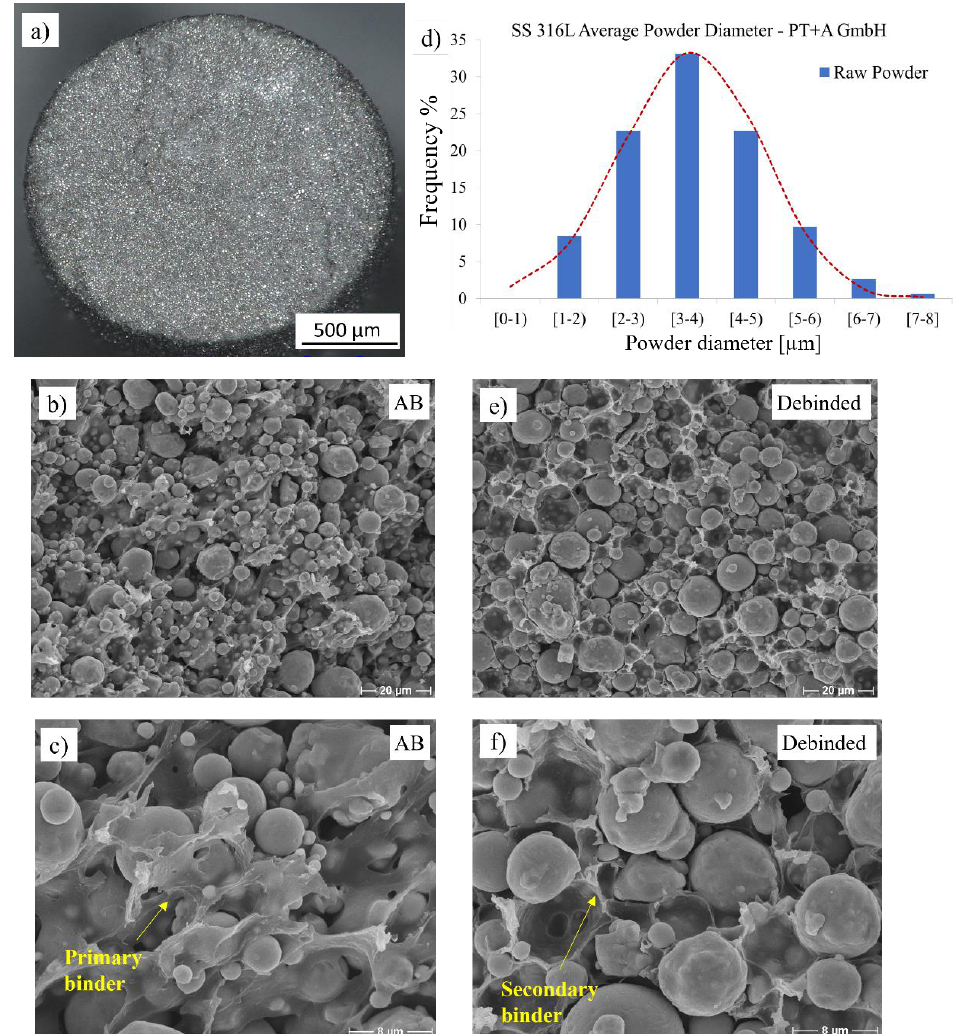
Figure 3. ( a ) Raw filament cross-section at mag. 50 × , ( b ) micrograph of feedstock with stainless steel 316L powder embedded by polymeric binder at mag. 1000 × and ( c ) mag. 3000 × , ( d ) particle size distribution of measured powder in the debinded state, ( e ) micrograph of the debinded geometry at mag. 1000 × and ( f ) mag. 3000 × .